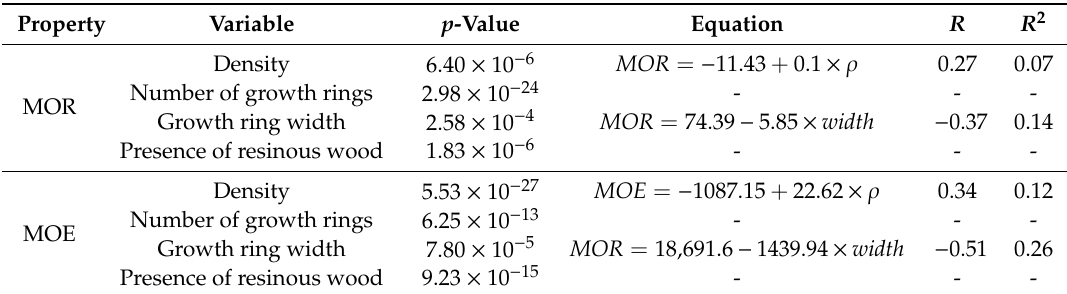
Table 6. Analysis of variance and correlation between density, number of growth rings, growth ring width and presence of resinous wood; and properties of bending strength (MOR) and modulus of elasticity (MOE), grouping grades ME-1 and ME-2.